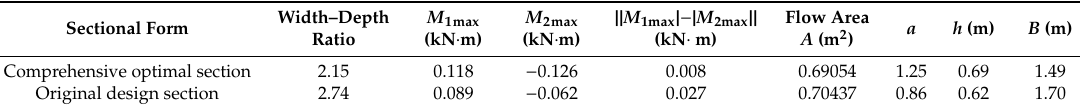
Table 1. Two types of channel section